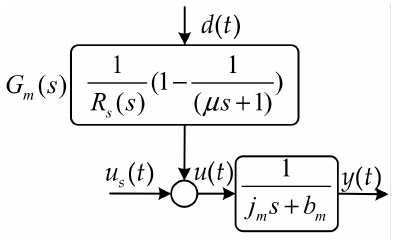
Figure 2. Equivalent simplified block diagram inner closed